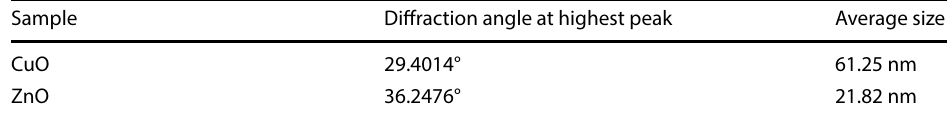
Fig. 5 FTIR Spectroscopy of synthesized CuO Nanopar-